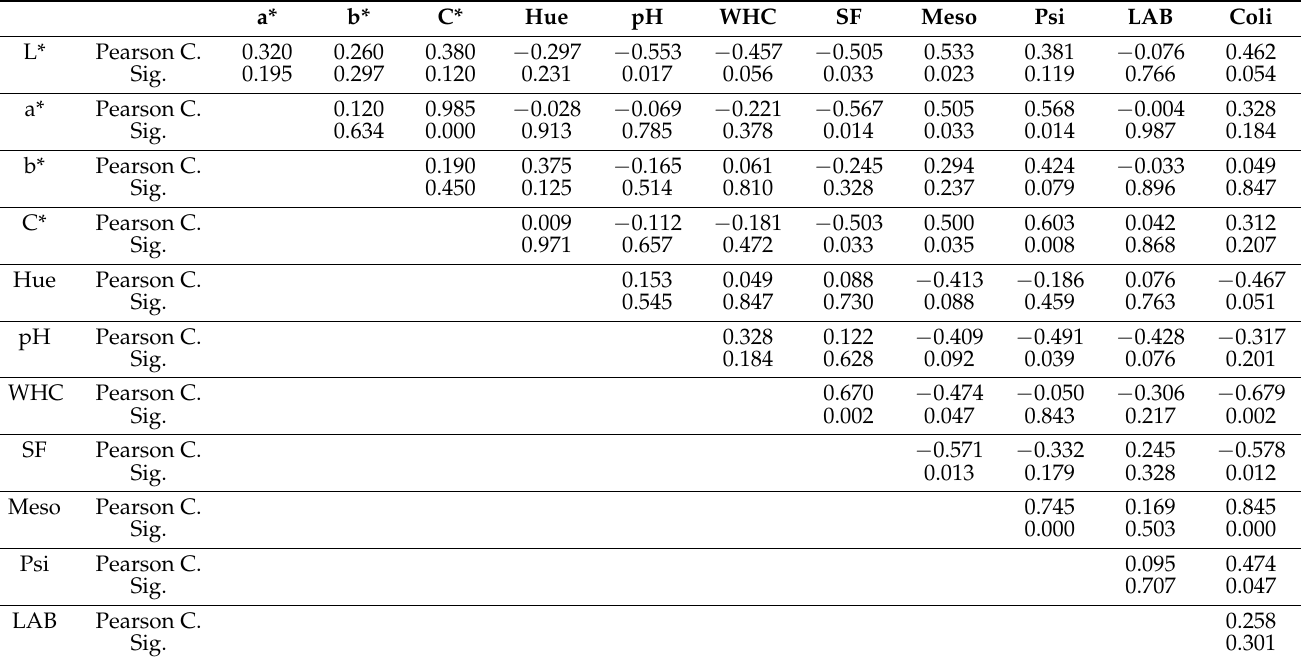
Table 3. Pearson correlations and significances among dependent variables of beef L. lumborum without or with HIU